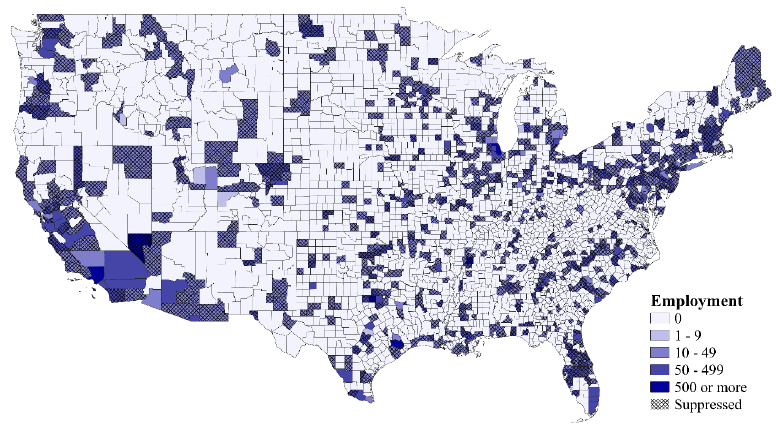
Figure A.3: Employment Distribution of Support Activities for Road Transportation